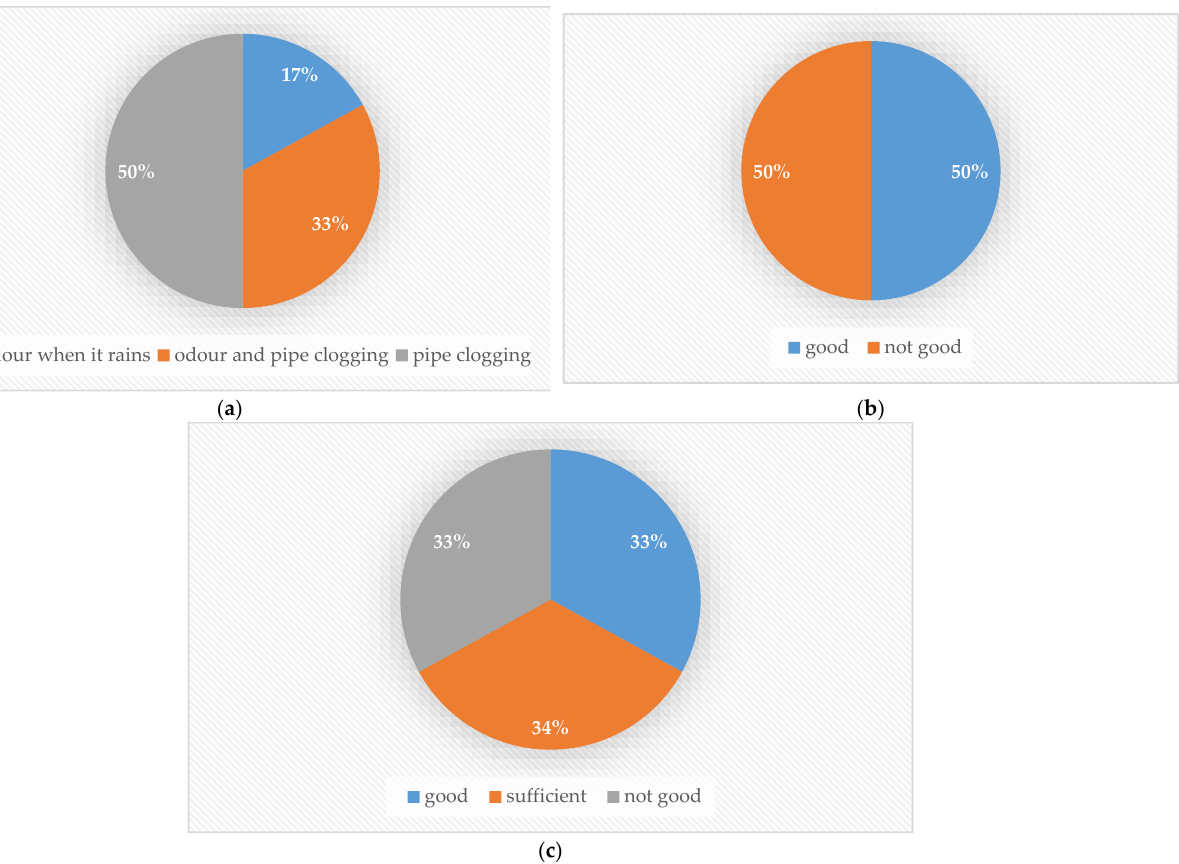
Figure 3. Results of survey of CWWTPs managers on ( a ) frequent problems in plant operations related to clogging and odors; ( b ) rating of the citizens’ engagement with the CWWTPs; and ( c ) reliability of CWWTP subscription fee payments by the citizens.